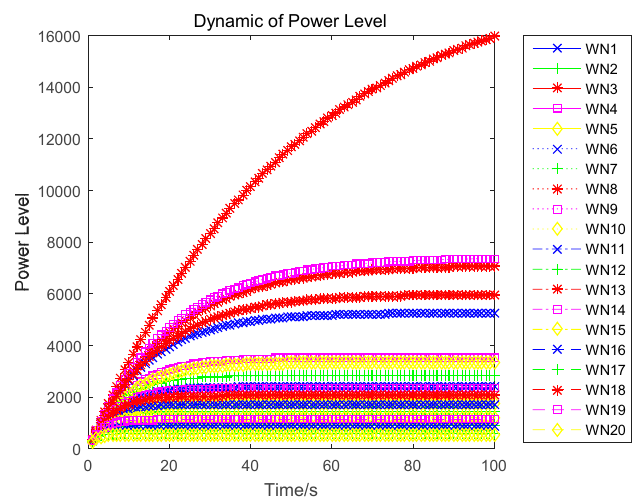
Figure 5. Variation of the optimal uplink power in infinite-horizon.